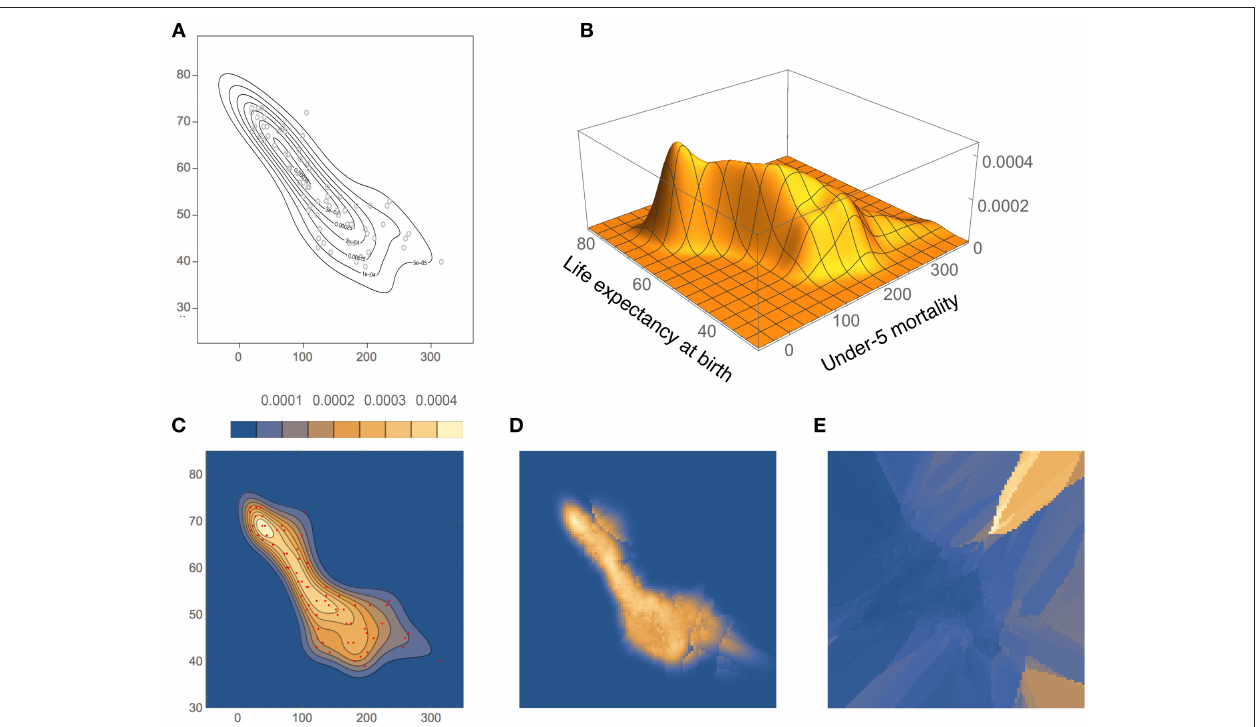
FIGURE 12 | Density estimates for the UNICEF data set, comparing our method (BADE) with BABM (Zougab et al., 2014). (A) BABM estimate. (B) BADE estimate. (C) BADE estimate shown as a contour plot, along with the sample points. (D) Effective k values (i.e., k e ) on a grid of size 100 grid. Both k e and V k are the ones before applying the covariance smoothing